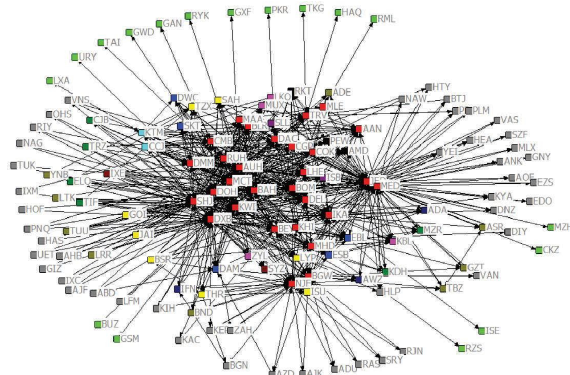
Figure 6: K -core decomposition of West Asia and North Africa